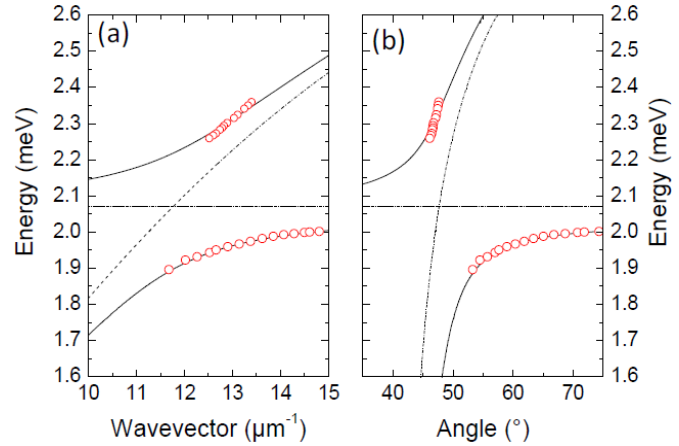
Figure 3. Reflectometry dip energy position (open circles) as a function of ( a ) the wavevector and ( b ) the angle. The dashed lines correspond to the calculated bare plasmon and exciton position, the solid lines to the calculated polaritonic